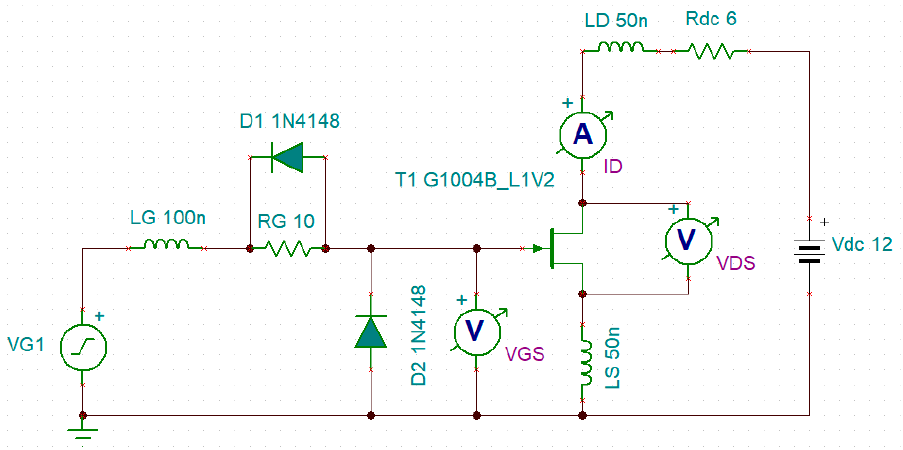
Figure 2. Circuit simulation in TINA-TI.